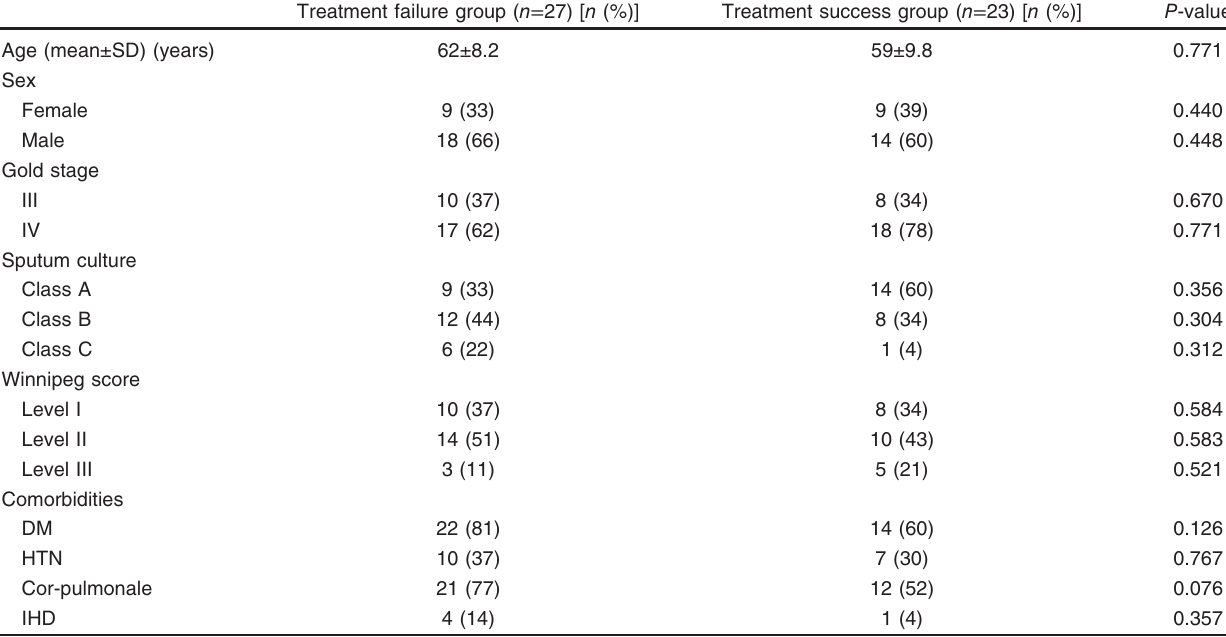
Table 1 Demographic and clinical data of treatment failure and treatment success groups among chronic obstructive pulmonary disease patients Treatment failure group ( n = 27) [ n (%)]